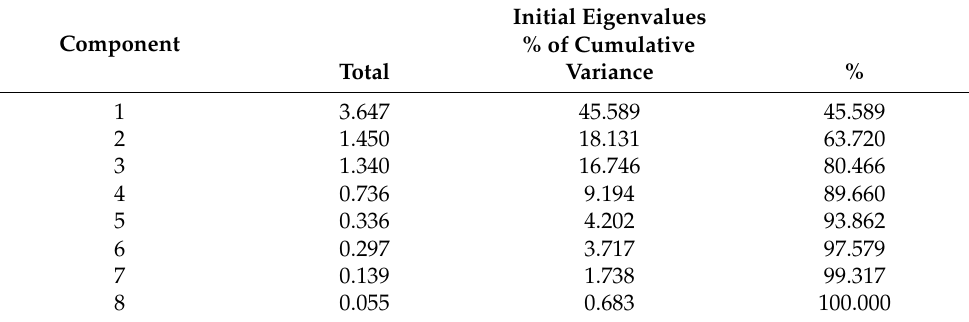
Table 2. Total variance explained.